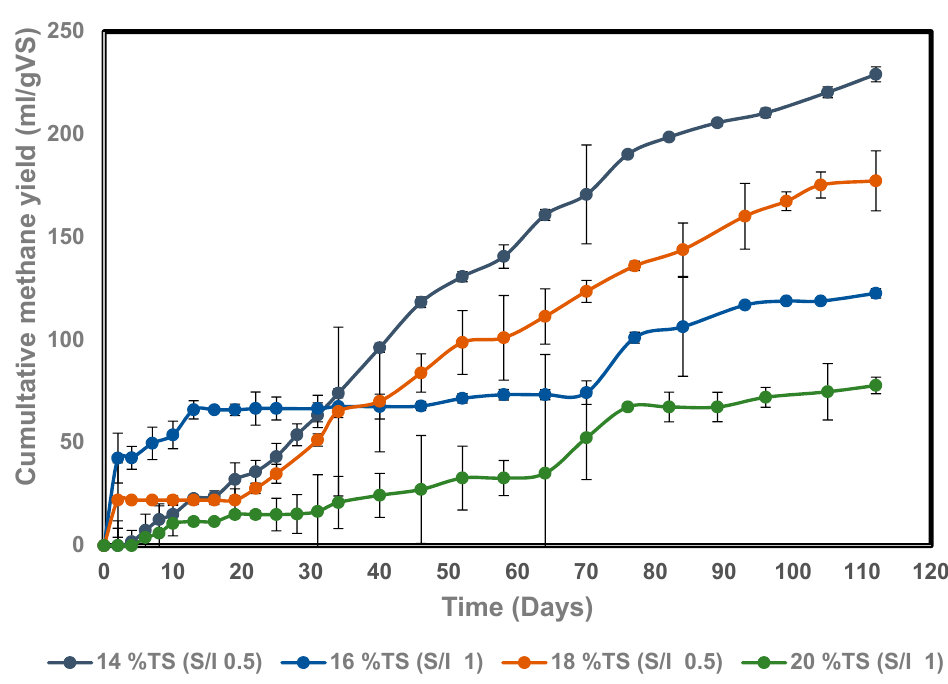
Figure 3. Cumulative methane yield of paper wastes at different total solid (TS) concentrations of the mixture in reactors at inoculum to substrate ratios (I/S) of 2:1 and 1:1.